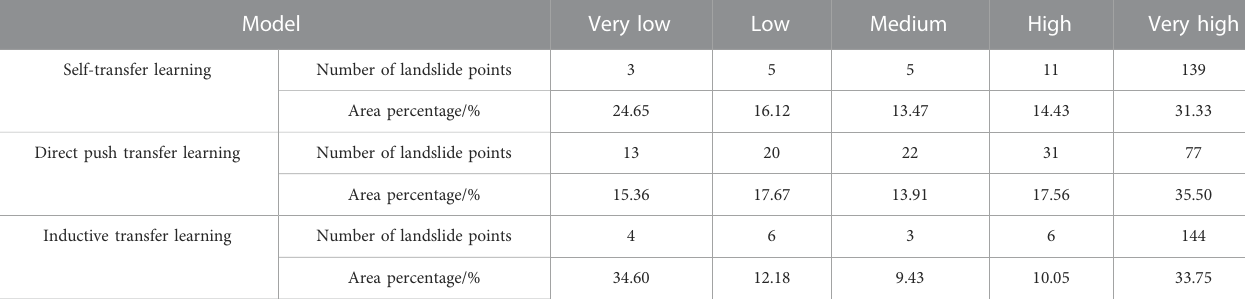
TABLE 5 Distributions of landslides and area percentage under different susceptibility